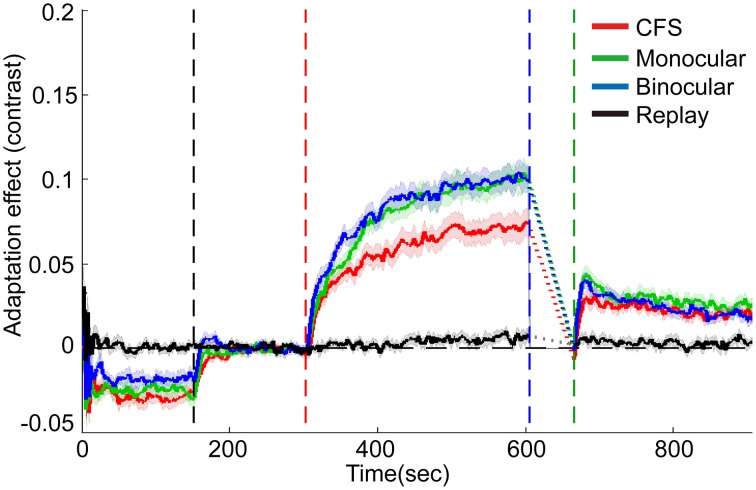
Grand average timecourses for three conditions and replay sessions in Experiment 1. Shaded regions show ±1 s.e of the mean. Because of variable deadaptation duration across conditions, timecourses during deadaptation were not plotted but substituted by dashed lines. Adaptation effects were normalized by subtracting average matching contrasts of the last 15 reversals in the baseline period. The horizontal dashed lines represent the normalized baselines. The four vertical dashed lines denote the start time for the baseline, adaptation, deadaptation, and post-test period, respectively.